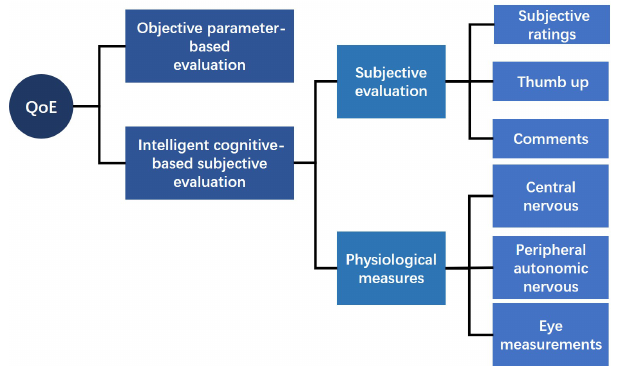
Figure 1. The evaluation methods of